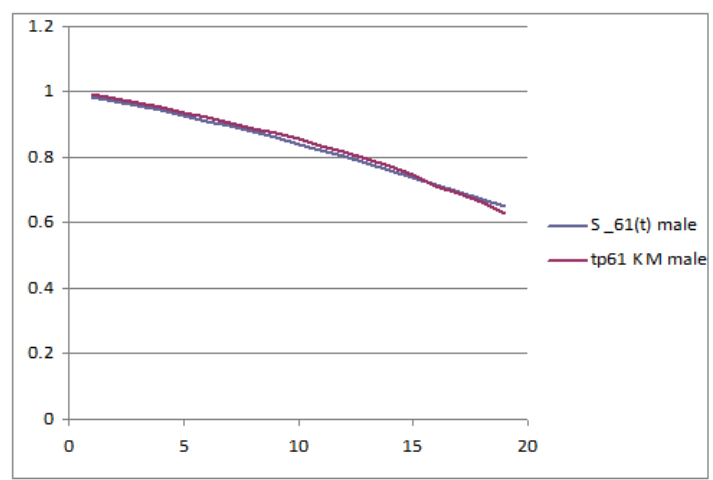
Figure 4. Males, young generation.